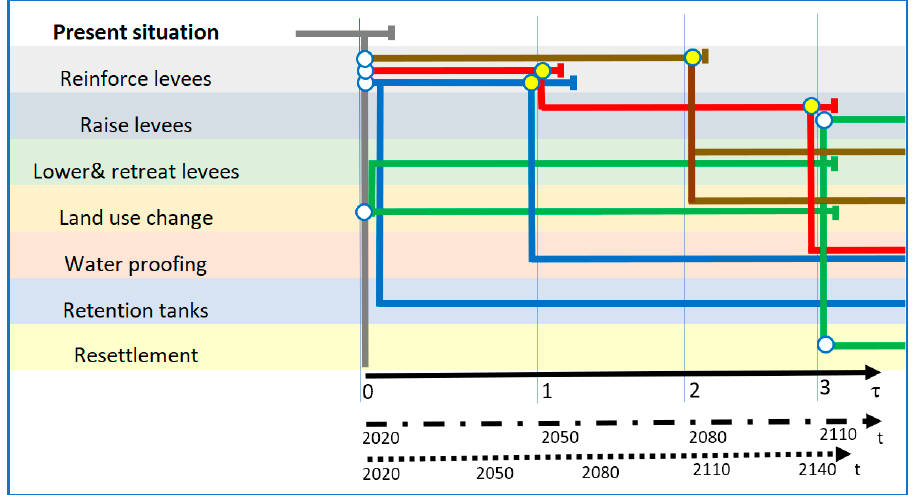
Figure 14. Some possible strategies for a river management problem (based on structural interventions) that can be undertaken as soon as current river setting is perceived to be inadequate (yellow dot) because of changed external conditions (particularly climate), denoted by a short vertical segment. This depends on the speed of climate change, as depicted by the lowest time axis (lower and faster speed, respectively) and determines decision steps at intervals of different duration. (Source: inspired by a similar figure from CRIDA UNESCO course 2021, https://openlearn- ing.unesco.org/courses/;